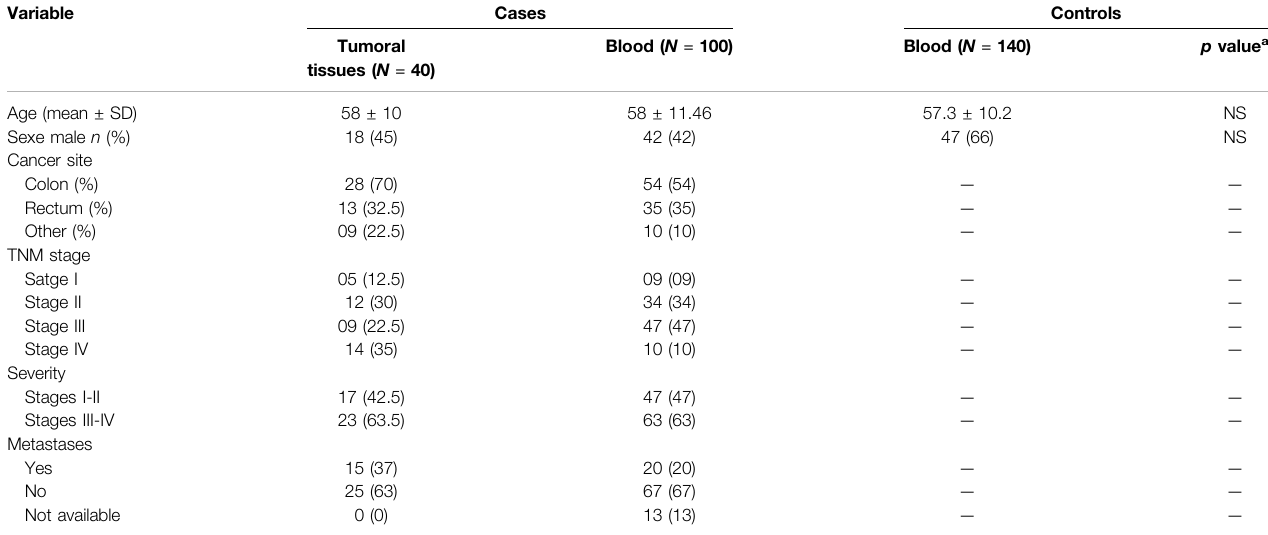
TABLE 1 | Clinical characteristics of patients with CRC and control groups. Variable